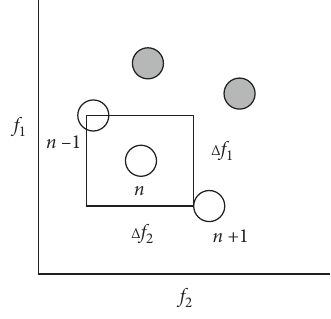
Figure 4: Crowding distance for node n